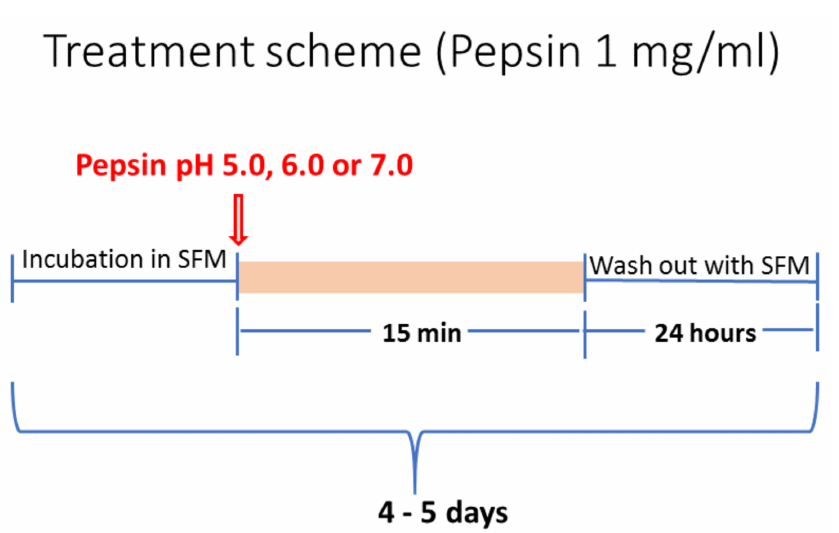
Figure 8. Schematic representation of pepsin-application in exposed HCs at variable pH (5.0, 6.0 and 7.0). (SFM: serum free